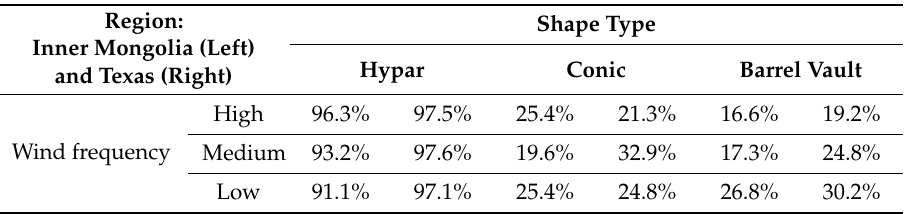
Table 2. Reduction rate of the acceleration value.